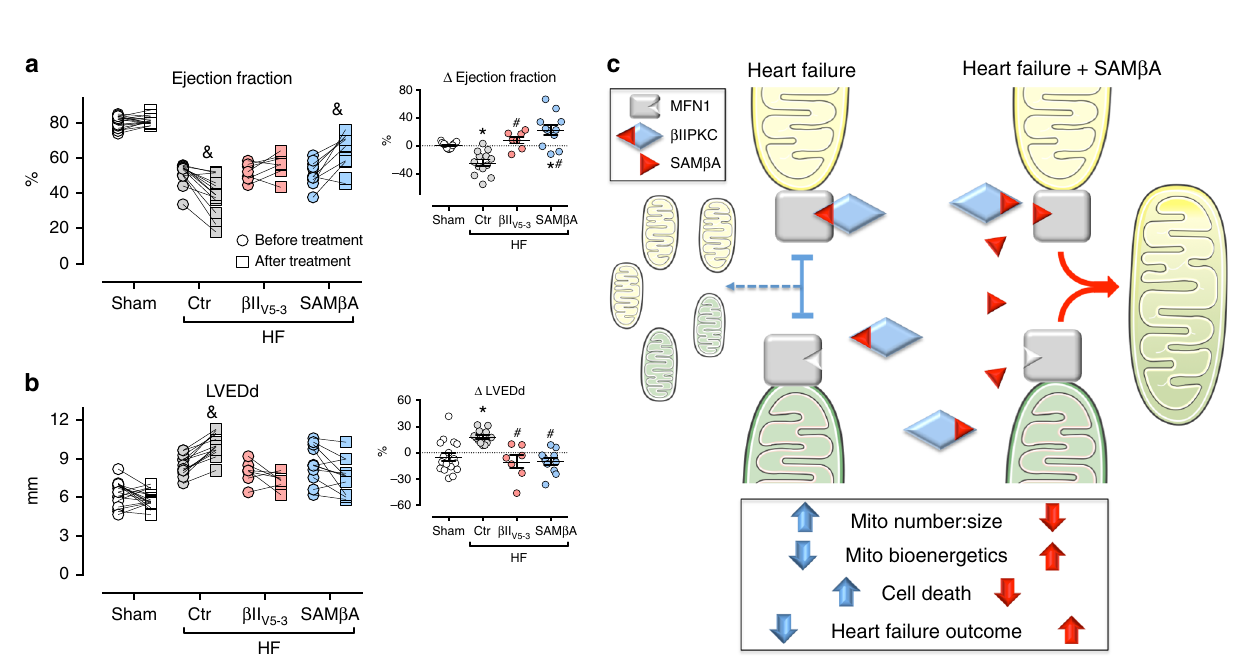
Fig. 7 Sustained SAM β A treatment results in better heart failure outcome. a Left ventricular ejection fraction and b LVEDd (left ventricular end-diastolic dimension) measured by echocardiography before and after treatment; input: delta of measurements performed before and after treatment, in animals from sham (white bars, n = 7), TAT-treated heart failure (HF-Ctr, gray bars, n = 9), β II V5-3 -treated heart failure (HF- β II V5-3 , red bars, n = 7), and SAM β A- treated heart failure groups (HF-SAM β A, blue bars, n = 11). Data are means ± SEM. * P < 0.05 vs. Sham rats. # P < 0.05 vs. HF-Ctr rats. & P < 0.05 vs. before treatment. One-way or two-way analyses of variance (ANOVA) with post-hoc testing by Duncan. For all the cardiac function studies, the observer was blinded to the experimental groups. c Proposed model for the SAM β A-mediated cardioprotection in post-myocardial infarction-induced heart